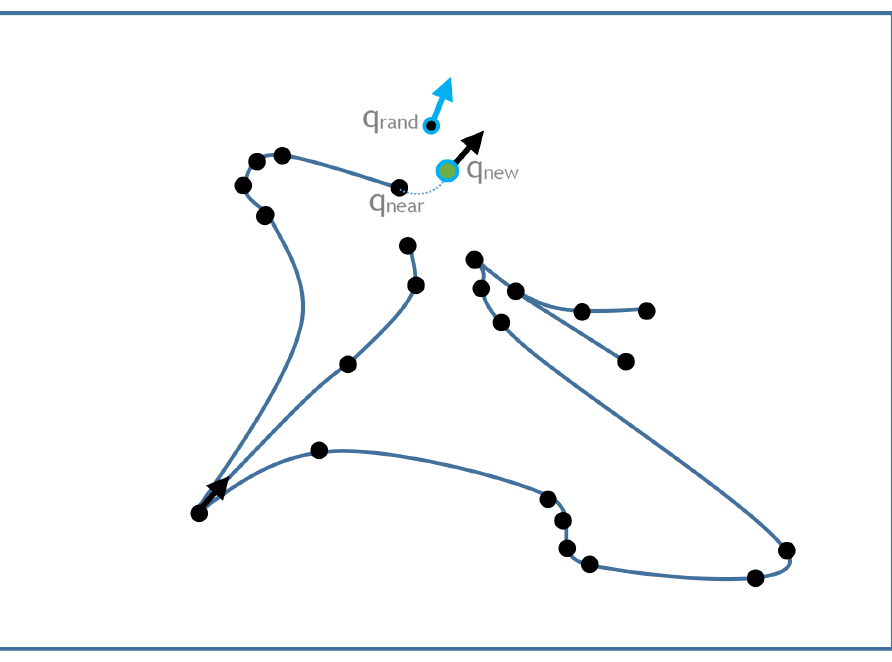
Figure 10. Sampling